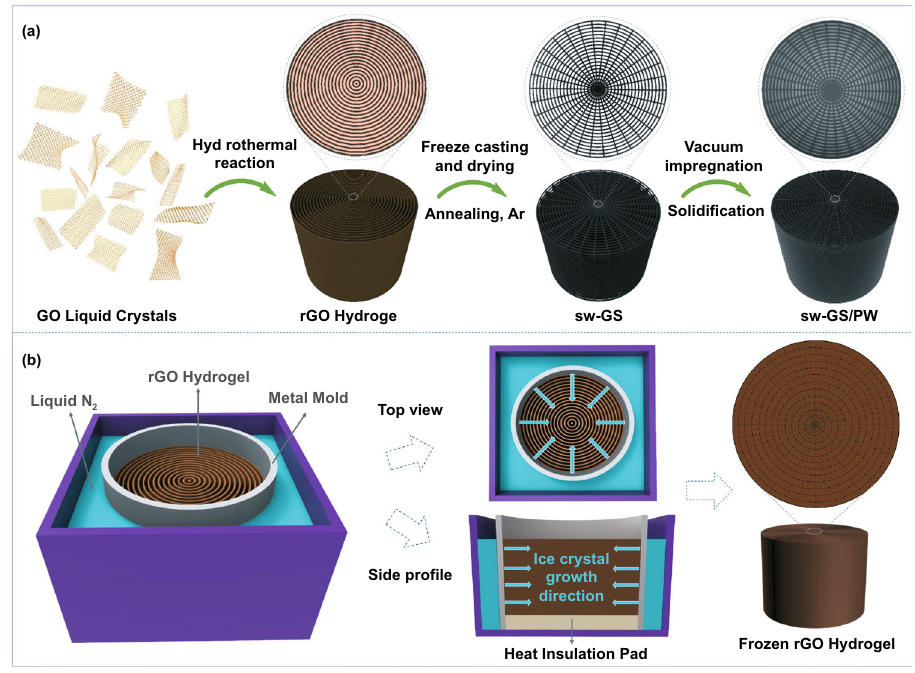
Fig. 1 a Schematic illustration for preparation of polymer composite, sw‑GS/PW. b Schematic diagram of radial freeze‑casting for rGO hydro‑